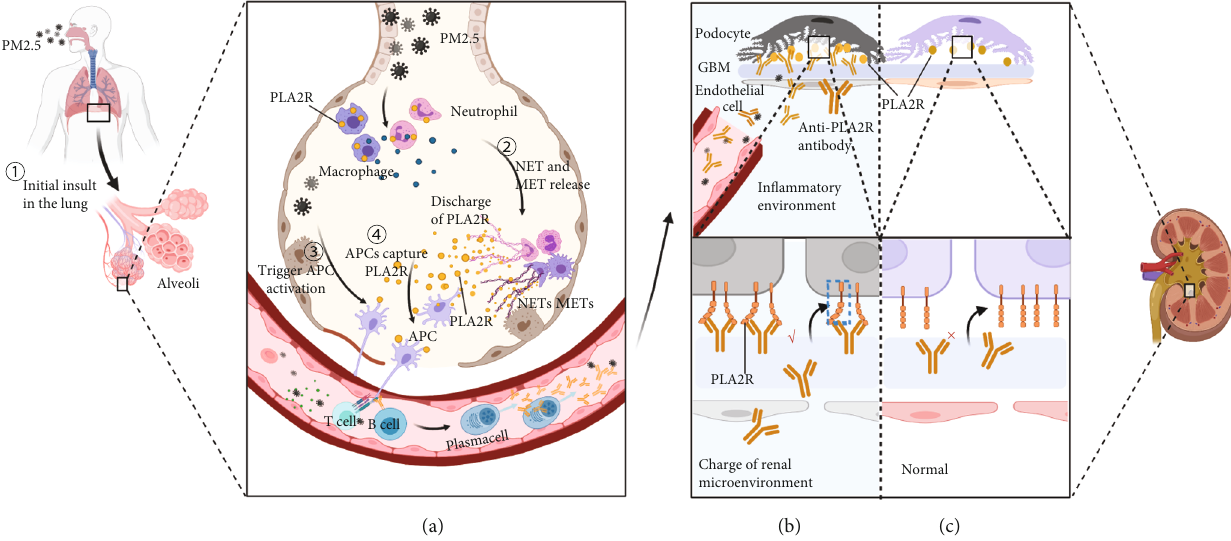
Figure 2: The hypothetical pathogenesis model of the relationship between the tumor and thrombospondin domain-containing 7A- (THSD7A-) associated membranous nephropathy (MN). (a) In theory, THSD7A acts as a potential tumor-associated antigen that is overexpressed by cancerous tissue allowing regional exposure of pathogenic epitopes of the autoantigen, which contributes to the production of anti-THSD7A antibodies. The extrarenal anti-THSD7A antibodies circulate into the glomerular capillaries and bind to THSD7A antigens located on podocytes. Besides, the tumor may alter the renal microenvironment that induces antigen conformational changes that allow binding of anti-THSD7A antibodies. (b) Pathogenicity of anti-THSD7A antibodies causing podocyte injury and proteinuria. The binding of anti-THSD7A antibodies to THSD7A on podocytes disrupts the slit diaphragm that allows albumin excretion into the urine, collapse of the actin cytoskeleton, and reduction of detachment from GBM. (c) The normal structure of podocyte foot processes. THSD7A that is present in foot processes closest to the slit diaphragm is involved in the stabilization of the slit diaphragm of mature podocytes, which forms the fi nal barrier to albumin permeation. Abbreviations: APC: antigen-presenting cell; TCR: T cell receptor; MHC: major histocompatibility complex; GBM: glomerular basement